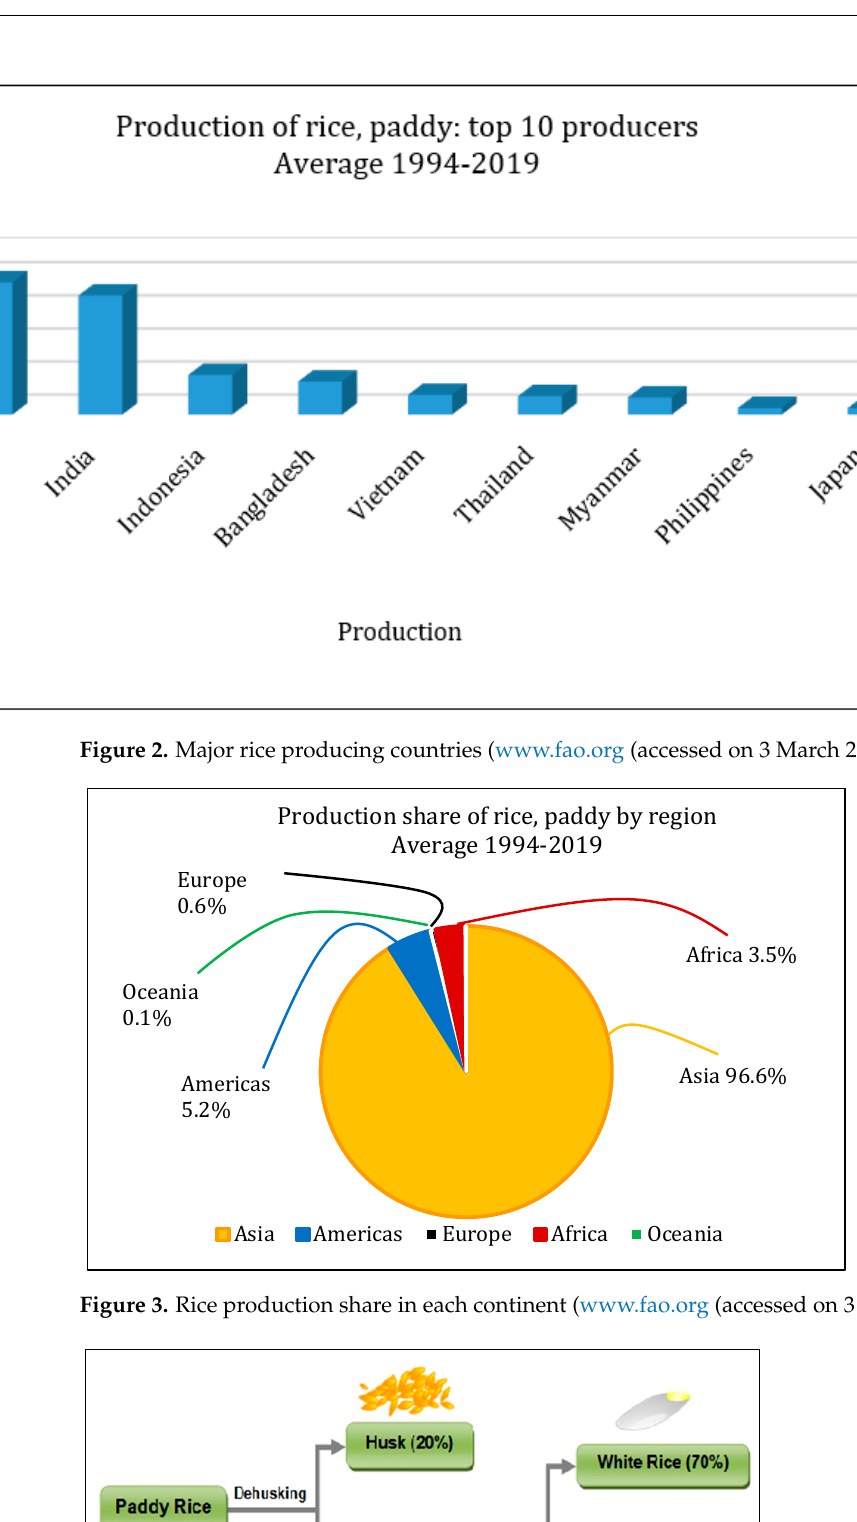
Figure 5. Some rice by-product applications. Most of the rice-producing countries suffer heavy and frequent losses in crop har- vest because of poor maintenance of technologies, inefficient supply chains, and farmers’ incapability to market the products. In research conducted by the World Bank and FAO, it has been claimed that, on average, around 8% to 26% of the rice produced in develop- ing nations is destroyed due to poor facilities and post-harvest problems (www.fao.org (accessed on 3 March 2022)). In addition, the rice-processing industry is heavily dependent on energy consump- tion. With environmental concerns such as greenhouse gas emissions, there is an urgent need to switch to non-carbon, renewable, and clean energy sources such as solar and bi- omass energy for rice processing [10]. Recent studies revealed that rice waste such as the husk and straw has great potential for electricity generation [8]. Instead of being dis- posed, rice waste that is properly used can bring about positive environmental effects (see Figures 6 and 7). Selecting an optimal combination out of traditional and renewable energy sources for rice production and processing can slightly lower some of the energy supply problems in this area [11].